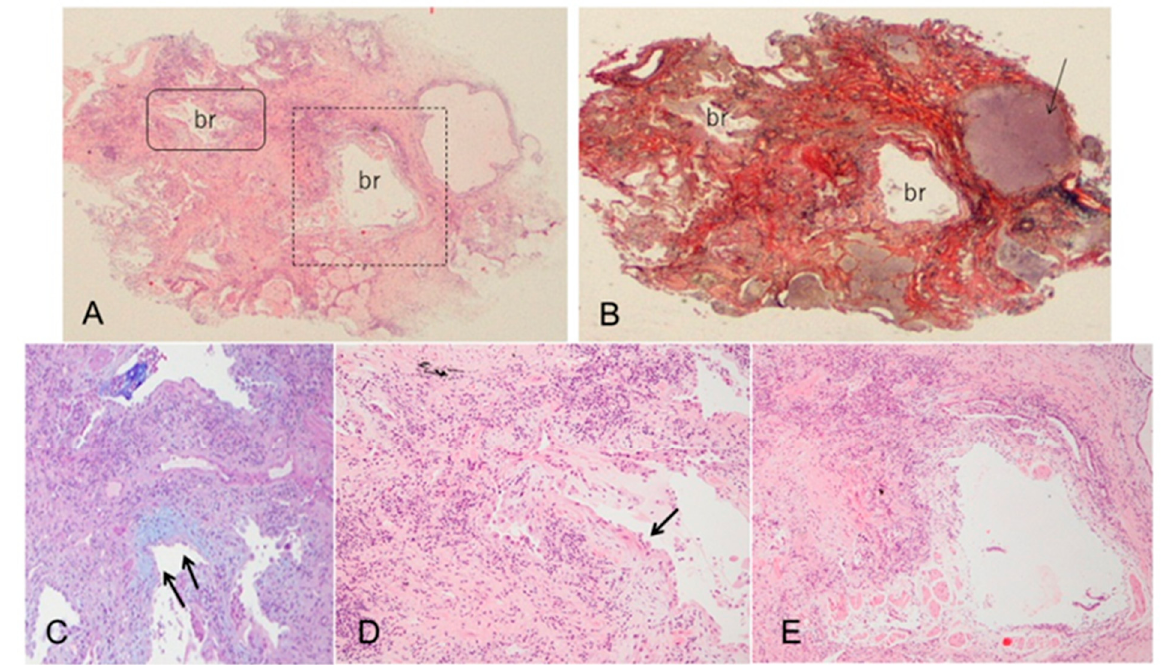
Figure 2. Transbronchial lung cryobiopsy in a case of MPO-ANCA-positive ILD. ( A ) Hematoxylin and eosin staining shows that the lesion is characterized by peribronchial dense fibrosis of alveoli with architectural destruction as a framework of usual interstitial pneumonia (UIP) pattern along with inflammatory cells in the interstitial tissue (×1) (Br, bronchus). ( B ) Elastica van Gieson staining shows partial loss of elastic lamina of a bronchiole as bronchiolitis and cystic air spaces filled with mucus (arrow) (×1). ( C , D ) A high-power magnification view of the closed square in ( A ) shows dilated bronchioles with subepithelial fibroblastic foci (arrows) and moderate infiltration of lymphocytes and plasma cells in the fibrosis ( C : ×2.5; Alcian blue staining, D : ×2.5; hematoxylin and eosin staining). ( E ) A magnified view of the dashed square in ( A ) shows a dilated bronchiole revealing shedding of epithelial cells, subepithelial fibrosis, and infiltration of lymphocytes and plasma cells, which defines bronchiolitis (×2.5; hematoxylin and eosin staining).